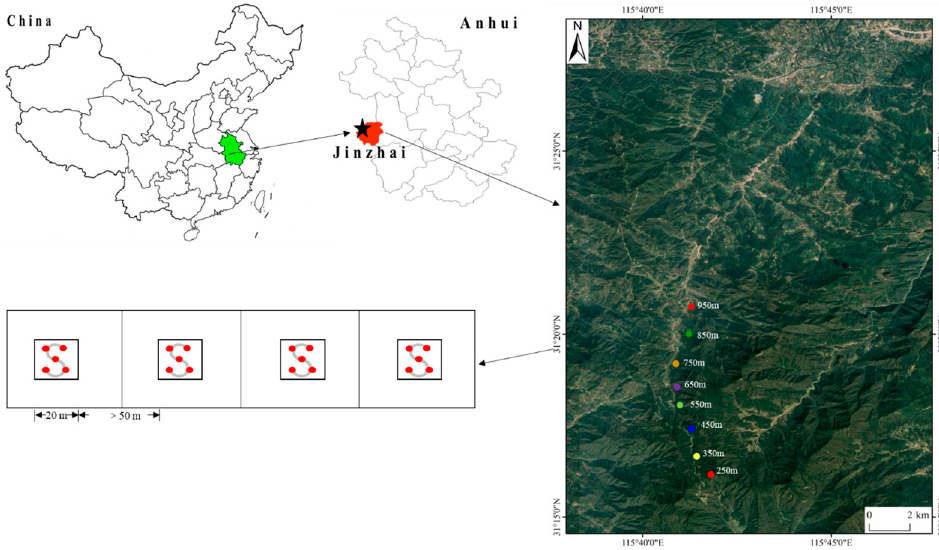
Figure 1. Location of the study area and experimental design. Soil samples were collected from the test site in August 2021. Following the removal of plants and litter from the ground surface of the plot, soil samples were extracted according to the “S” sampling technique using a 100 cm 3 ring knife. Five portions of the 0–20 cm soil layer were collected in each sample, mixed evenly, and stored in a sealed bag, for a